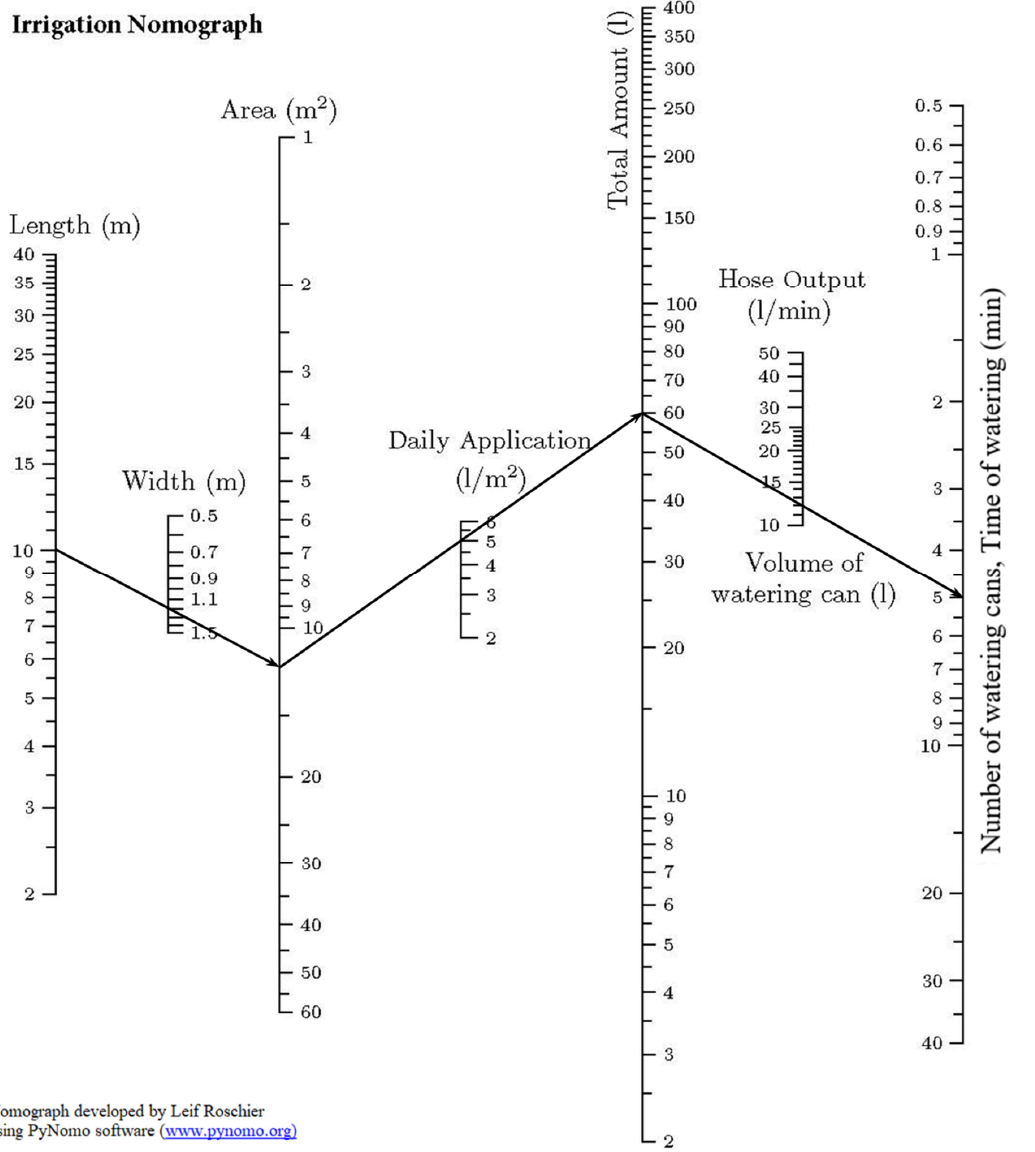
Figure 6. Nomograph developed for use by advisors and smallholder farmers in the study regions of Laos and Cambodia to calculate the number of watering cans, or duration of hose watering, required to apply the recommended daily irrigation application to leafy vegetables.